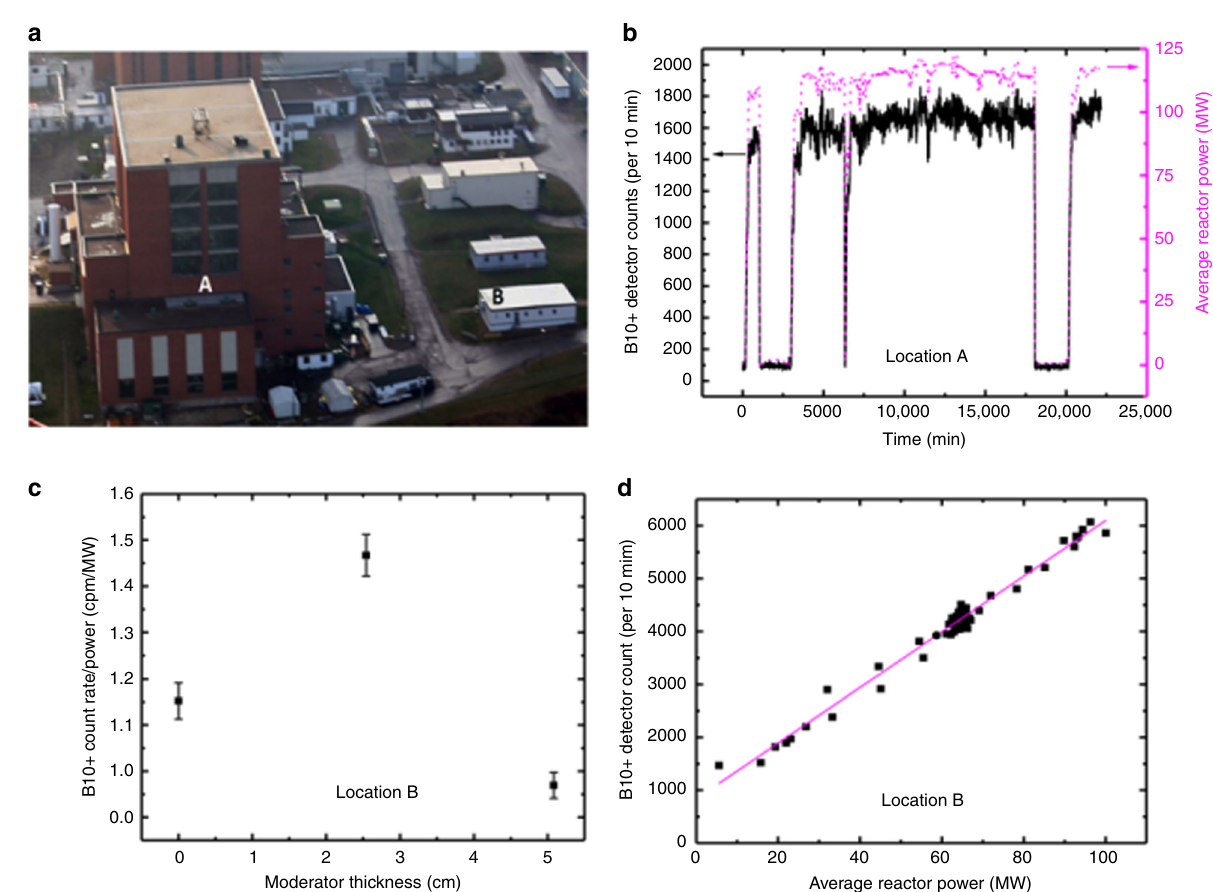
Fig. 1 Detector count rate variations with reactor power, time, and moderator thickness. a Aerial view of the National Research Universal (NRU) reactor building (image copyright ©Canadian Nuclear Laboratories), inside of which was positioned Location A, 17 m from, and 2 levels below, the reactor core, while Location B was situated at ground level in a trailer outside of the NRU reactor building, 69 m from the reactor core. b B10 + detector raw count rate (solid black curve) and reactor thermal power averaged over 10 min (dotted magenta curve) versus time at Location A. c Variations in B10 + detector raw count rate (using a single detector tube) at Location B with high-density polyethylene (HDPE) moderator thickness. Error bars are standard deviations of the mean. d Measured B10 + neutron detector raw count rate at Location B versus reactor thermal power averaged over 10 min during reactor start-up and shut-down periods, with a linear regression fi t to demonstrate their linear relationship. No corrections have been made for changing environmental factors Table 2 Intervening shielding/building material between the NRU reactor core and Locations (a) A and (b) B